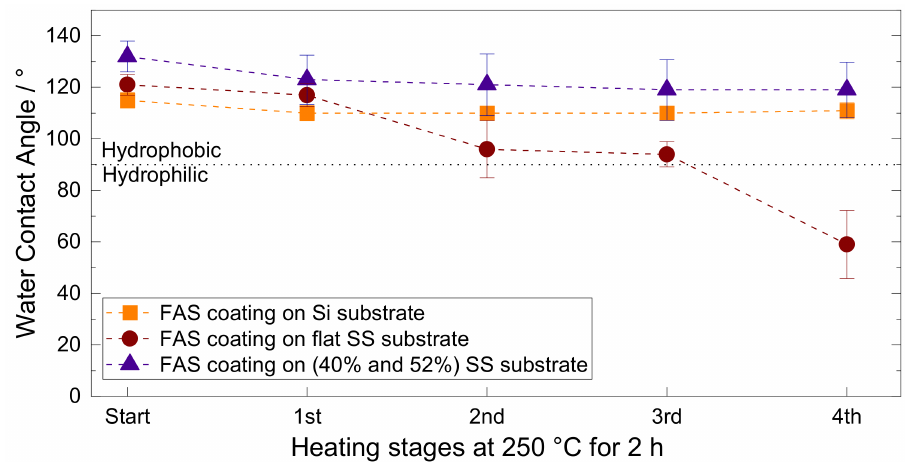
Figure 12. Results of the thermal resistance test for the FAS coating on different substrates.